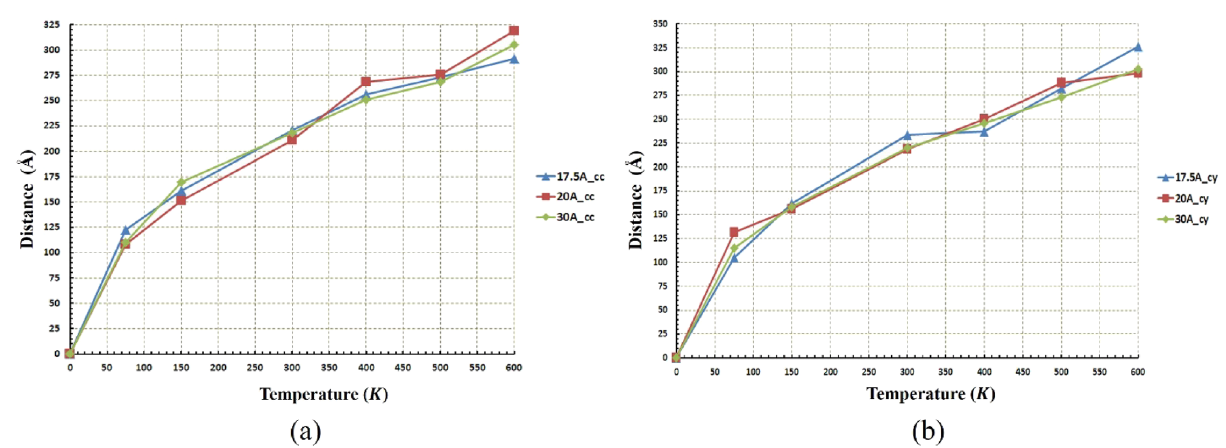
2 ) in all radii ps